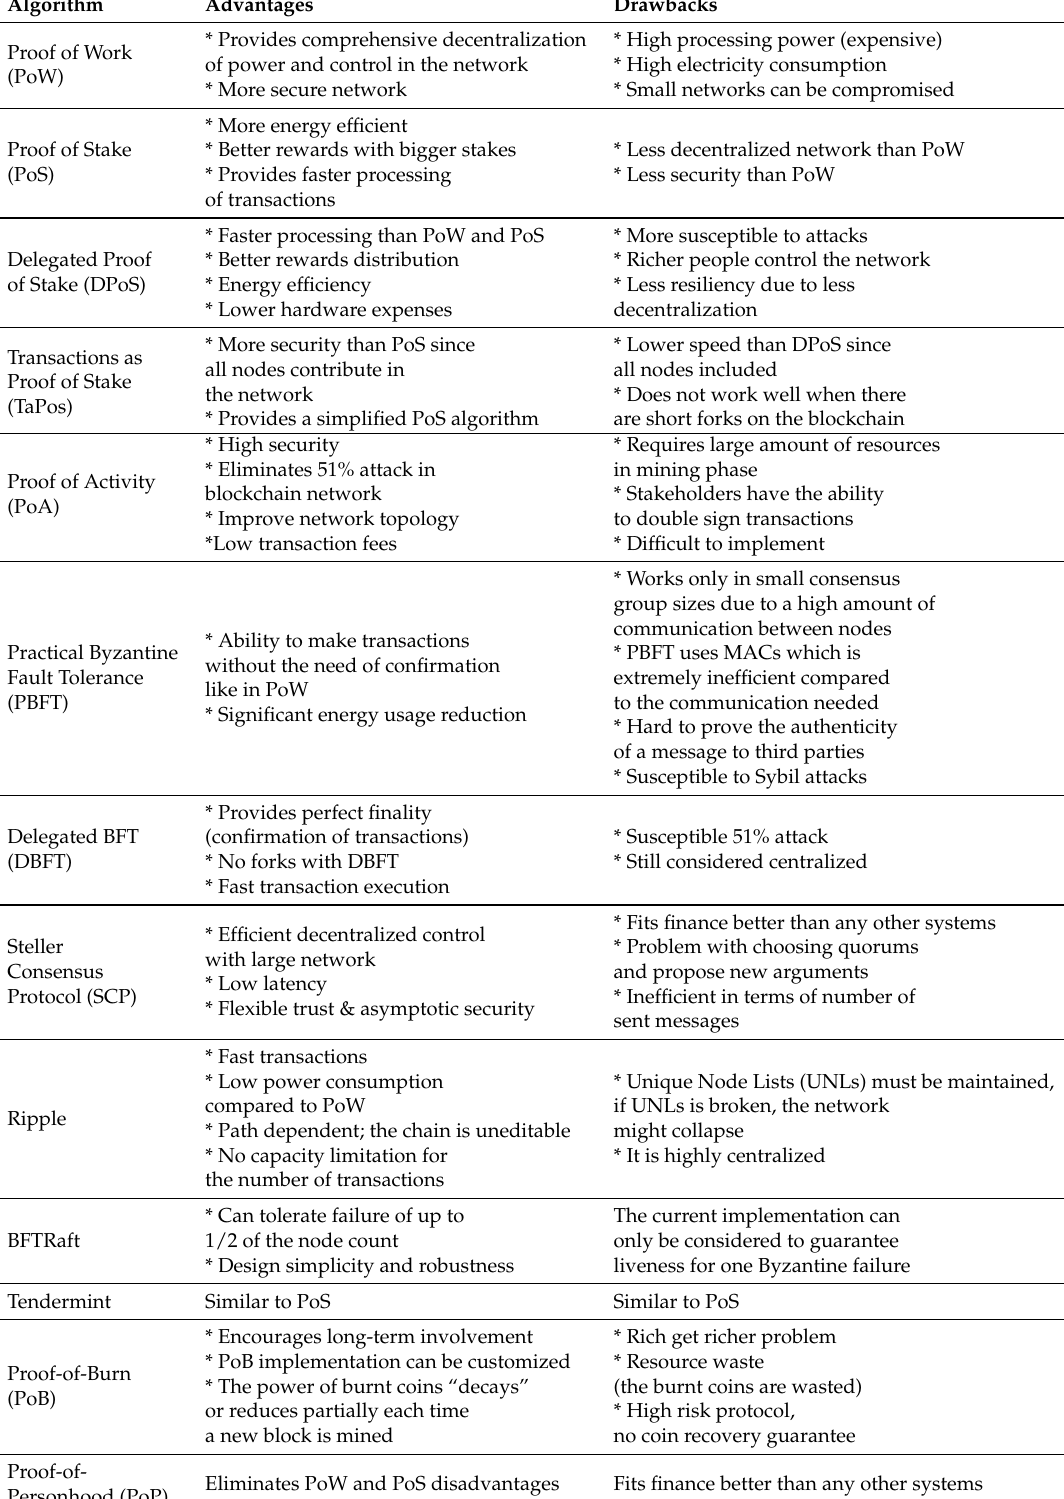
Table 1. Advantages and disadvantages of blockchain consensus